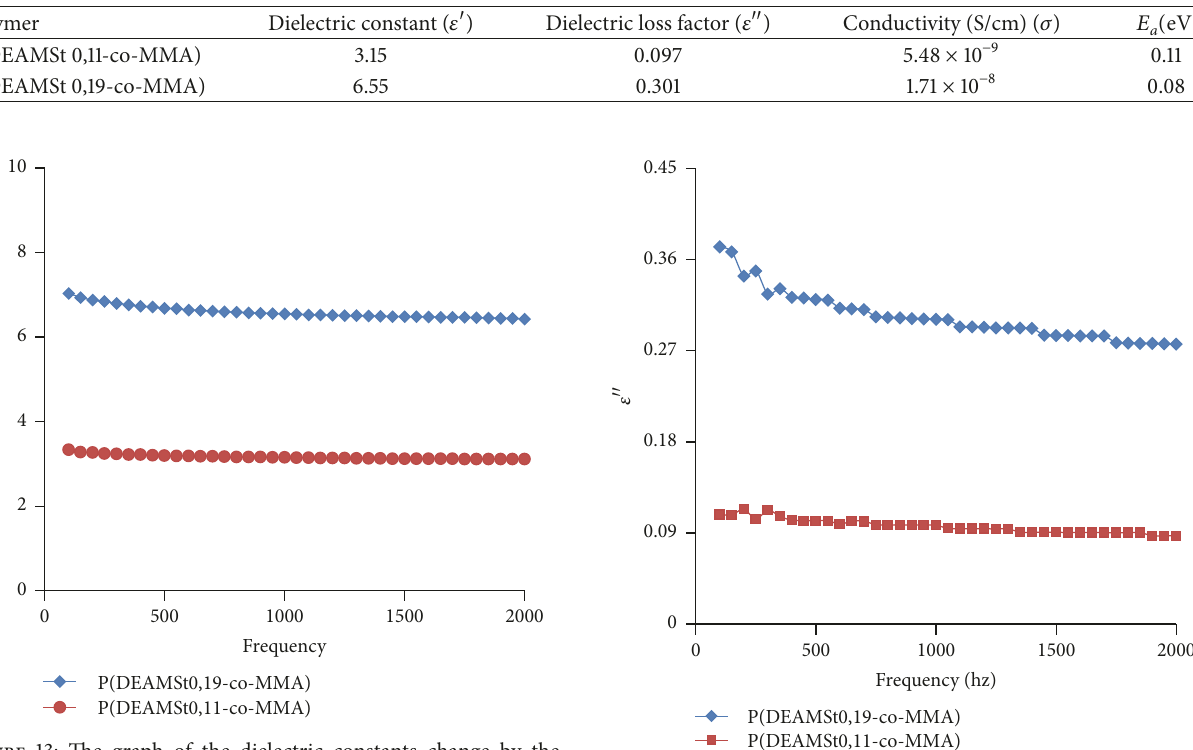
Table 6: The dielectric constant, dielectric losses factor, and conductivity values of P(DEAMSt-co-MMA).